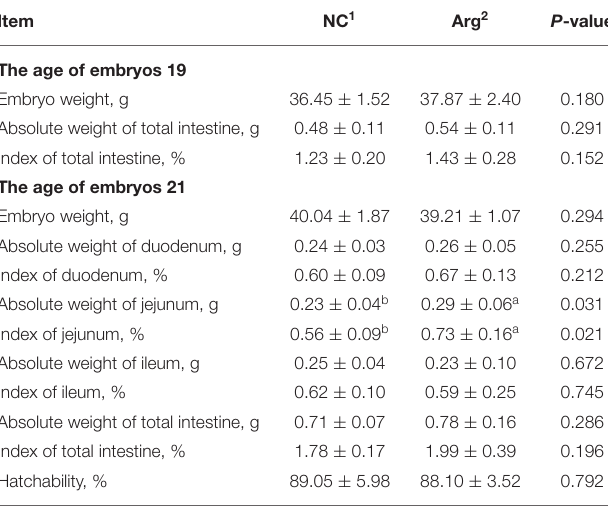
TABLE 1 | Effects of in ovo feeding of L -arginine on embryo